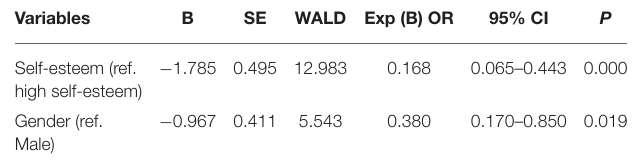
TABLE 5 | Factors affecting